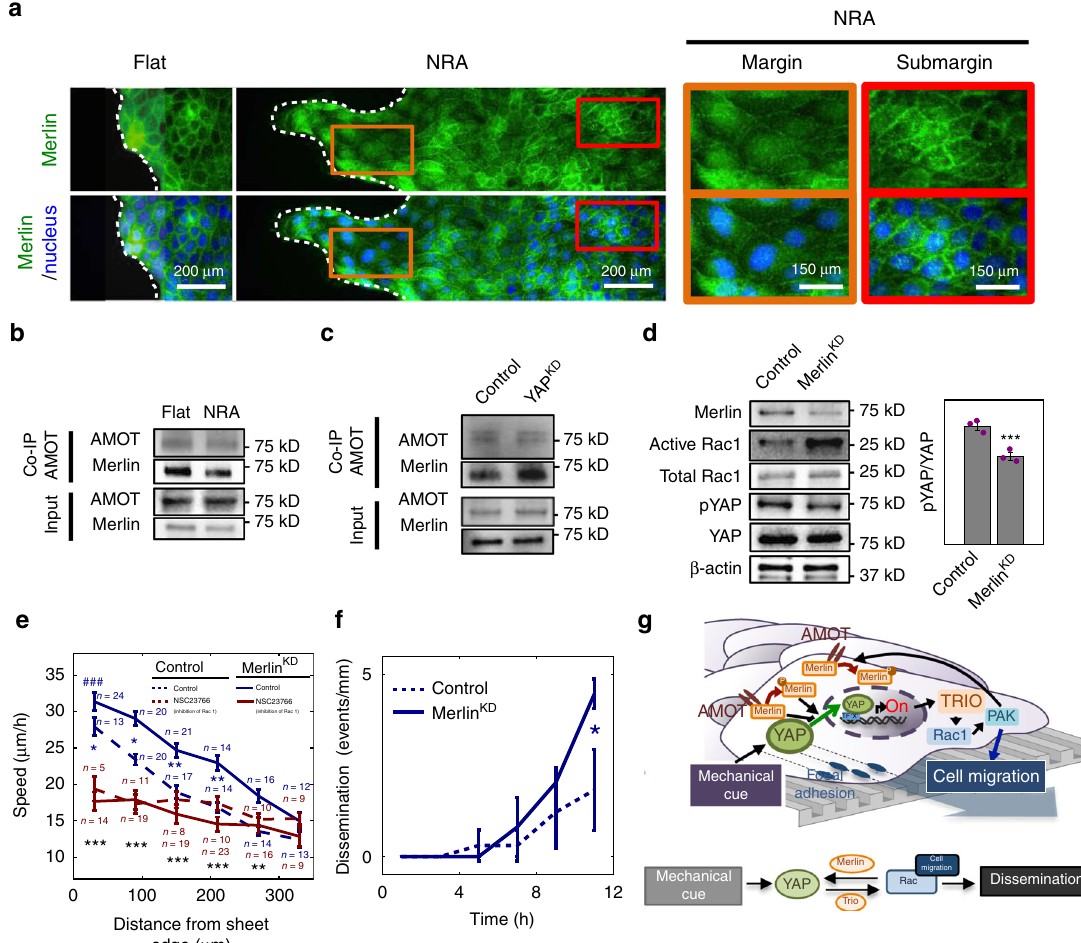
Fig. 6 Cross-regulation of YAP, Rac1, and Merlin in epithelial layers on NRA. a Immuno fl uorescence staining for Merlin in epithelial cell sheets on a fl at surface and NRA. In the marginal zone and FLPs of sheets on NRA, Merlin was primarily localized in the cytosol (brown boxes), whereas it was localized in the cell – cell contacts of submarginal cells cultured on NRA and fl at substrata (red boxes). The samples were fi xed after 8 h to remove stencils. b Cells on fl at surfaces and NRA were used for Co-IP analysis with the AMOT antibody for investigating physical bounding between AMOT and a target protein, Merlin, and the precipitates were immunoblotted using Merlin antibody. c Lysates from control and YAP KD cells were used for co-immunoprecipitation (Co-IP) study using the AMOT antibody, analyzed by immunoblotting with Merlin antibody. d Control and Merlin KD cells were immunoblotted for evaluation of Rac1 activity via pull-down assay, YAP expression, and its phosphorylation. ( n = 3 biologically independent samples, * = statistical signi fi cance of the ratio of active Rac1 to Rac1 on control vs. Merlin KD cells. *** P < 5 × 10 − 3 ). e Cell migration speed of individual cells in Merlin KD epithelial cell sheets as a function of the distance from the sheet edge in cell sheets cultured on NRA in the presence of a Rac1 inhibitor, NSC23766. (each number of independently analyzed cells, n , is indicated, # = statistical signi fi cance of speed values in the marginal region vs. the most submarginal region of Merlin KD cells, ### P < 5 × 10 − 6 . * = statistical signi fi cance of control vs. Merlin KD cells without drugs (blue) and of Merlin KD cells with vs. without drugs (black), * P < 0.05 and ** P < 5 × 10 − 3 ). f Dissemination of cells in control and Merlin KD epithelial sheets on NRA. All error bars are S.E.M. ( n = 4 biologically independent experiments, * = statistical signi fi cance of the number of disseminations of cells from control vs. Merlin KD epithelial sheets, * P < 0.05). g Schematic of YAP-mediated signaling cascades operating via Rac1 and Merlin, controlling cell speed in cells undergoing partial and complete EMT. All error bars are S.E.M and statistical signi fi cance was determined by two-sided Student ’ s t